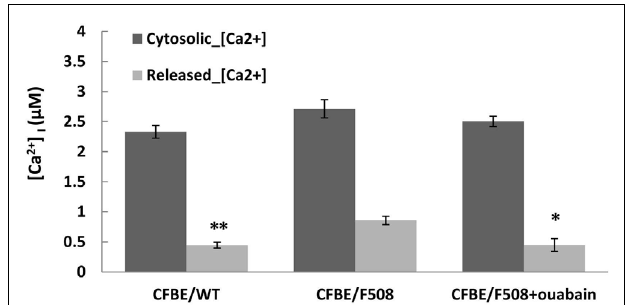
FIGURE 5 | Ouabain reduced the ER calcium stores in CFBE cells. CFBE/WT-CFTR and CFBE/F508del-CFTR cells were treated with, or without-, 100nM ouabain for 24h.The cells were then loaded with Fura-2/AM, and peak cytosolic Ca 2 + concentration was measured as the difference in Fura-2 fluorescence recorded before and after adding 2 µ M thapsigargin. Data are mean ± SD of n = 6 (* P < 0.015; ** P <